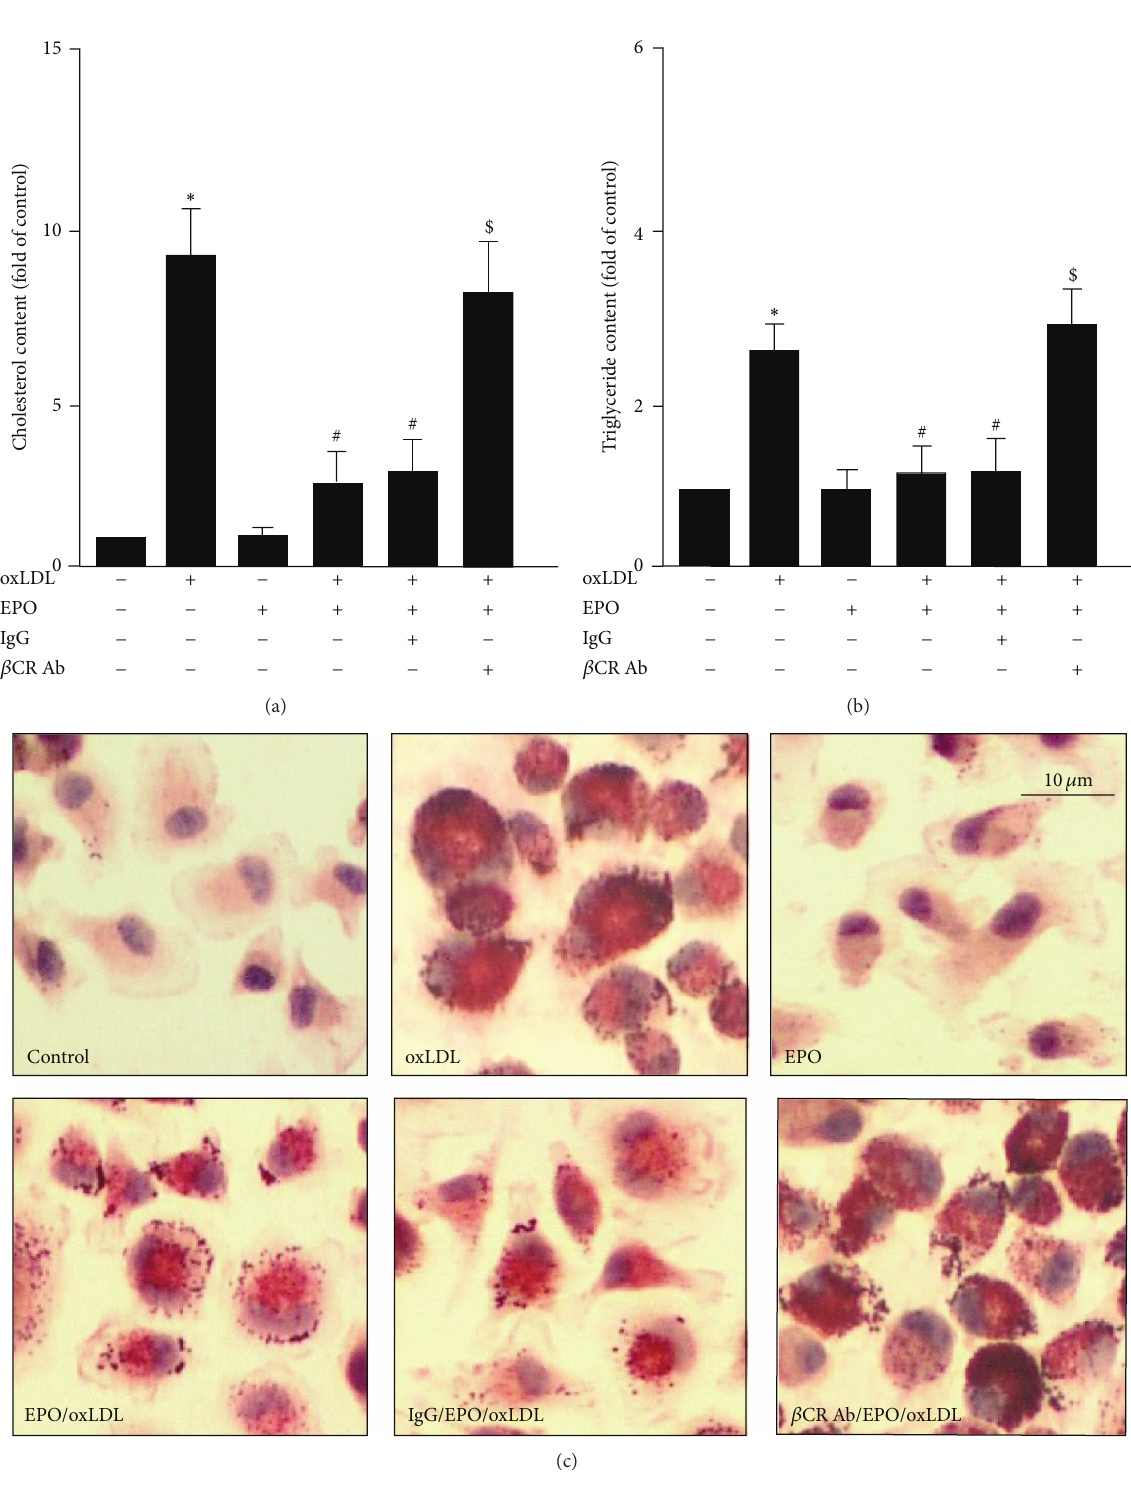
Figure 4: 𝛽 CR neutralizing Ab diminishes the EPO-mediated protection of oxLDL-induced lipid accumulation in macrophages. Bone- marrow-derived macrophages were pretreated with IgG (200ng/mL) or 𝛽 CR neutralizing Ab (200 ng/mL) for 2 h and then treated with EPO (5U/mL) for 12h, followed by oxLDL (50 𝜇 g/mL) for additional 18h. ((a) and (b)) The intracellular levels of cholesterol (a) and triglyceride (b) were extracted by hexane/isopropanol (3/2, v/v) and analyzed by colorimetric assay kits or (c) subjected to oil-red O staining. Cellular nuclei were stained with hematoxylin. Data is mean ± SEM from 5 independent experiments. ∗ 𝑃 < 0.05 versus vehicle-treated group, # 𝑃 < 0.05 versus oxLDL alone-treated group, $ 𝑃 < 0.05 versus oxLDL+EPO-treated